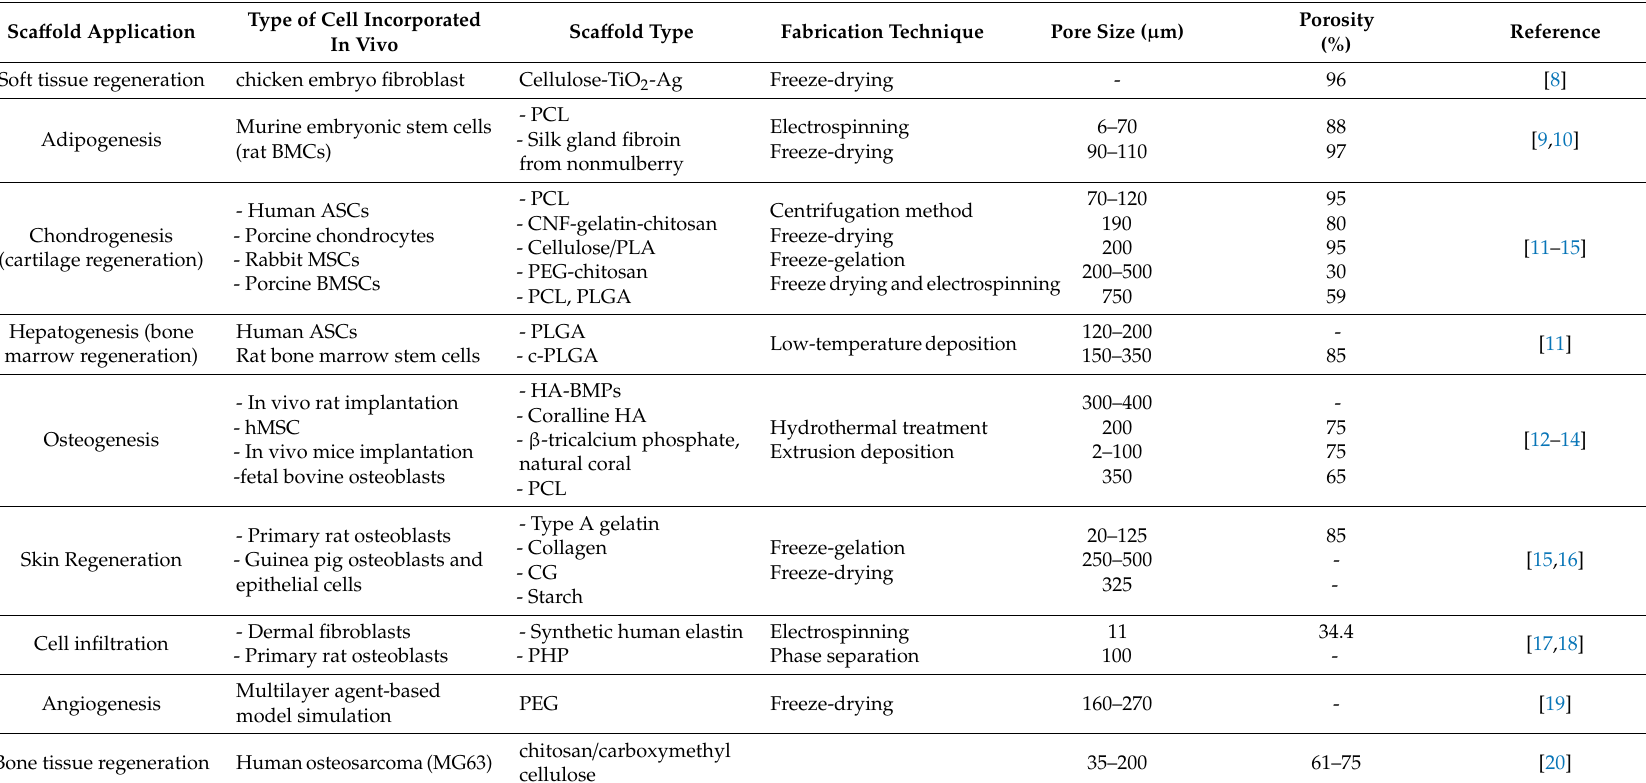
Table 1. Di ff erent sca ff olds with di ff erent porosities were used for di ff erent cell